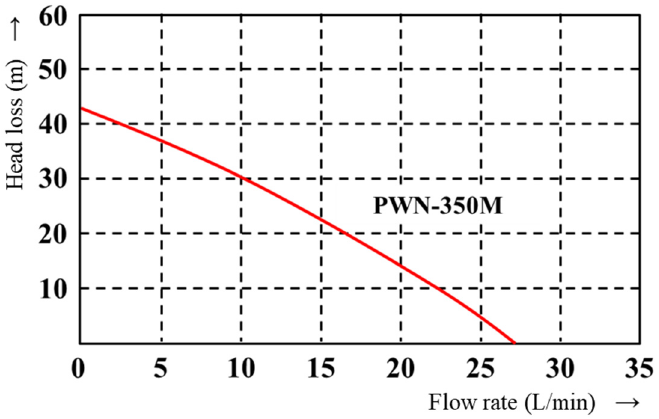
Figure 6. Pump performance curve.